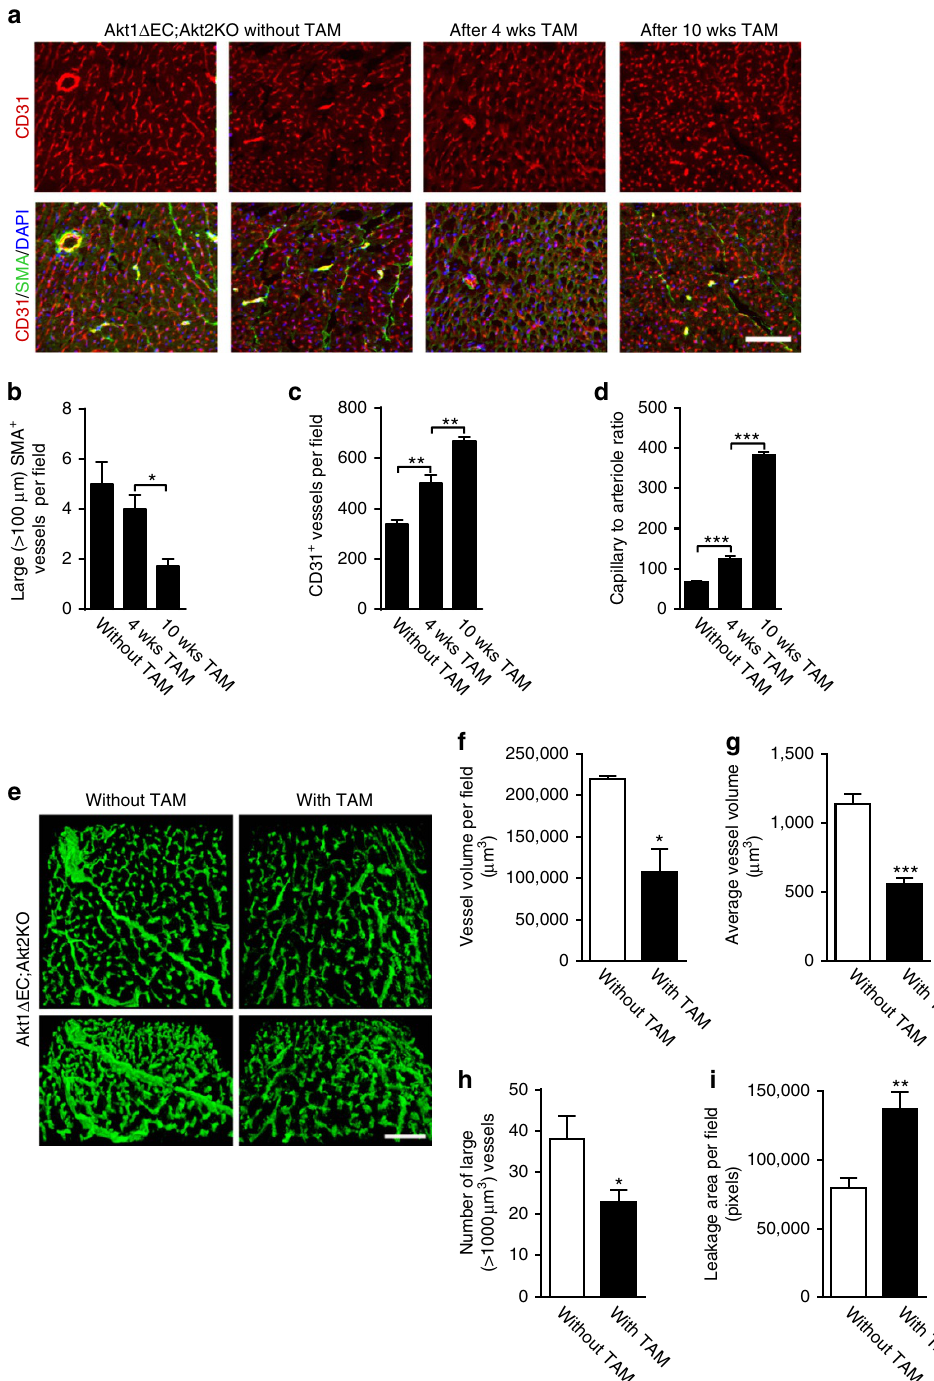
Figure 2 | Vascular regression and vascular patency on tamoxifen administration. ( a ) Representative images of Akt1 D EC;Akt2KO 13- to- 14-week-old mice heart sections stained for CD31 (red), SMA (green) and DAPI (blue) without tamoxifen (TAM), and 4 and 10 weeks (wks) after Akt1 excision (5 days of i.p. tamoxifen injection followed by 3 or 9 weeks of tamoxifen diet). Scale bar, 100 m m. ( b – d ) Quantification of 4 100 m m (large) SMA þ or CD31 þ vessels per field and capillary (CD31 þ SMA (cid:2) ) to arteriole (CD31 þ SMA þ ) ratio represented as mean ± s.e.m. ( n ¼ 4). ( e ) Representative images of Akt1 D EC;Akt2KO hearts of littermate mice perfused with lectin with and without TAM treatment for 4 weeks. Scale bar, 100 m m. ( f – i ) Quantification of vessel volume per field, average vessel volume, large vessel number ( 4 1,000 m m 3 ) and leakage area per field represented as mean ± s.e.m. ( n ¼ 3–5). * P o 0.05, ** P o 0.01 and *** P o 0.005 by one-way analysis of variance ( b – d ) or Student’s t -test ( f – i